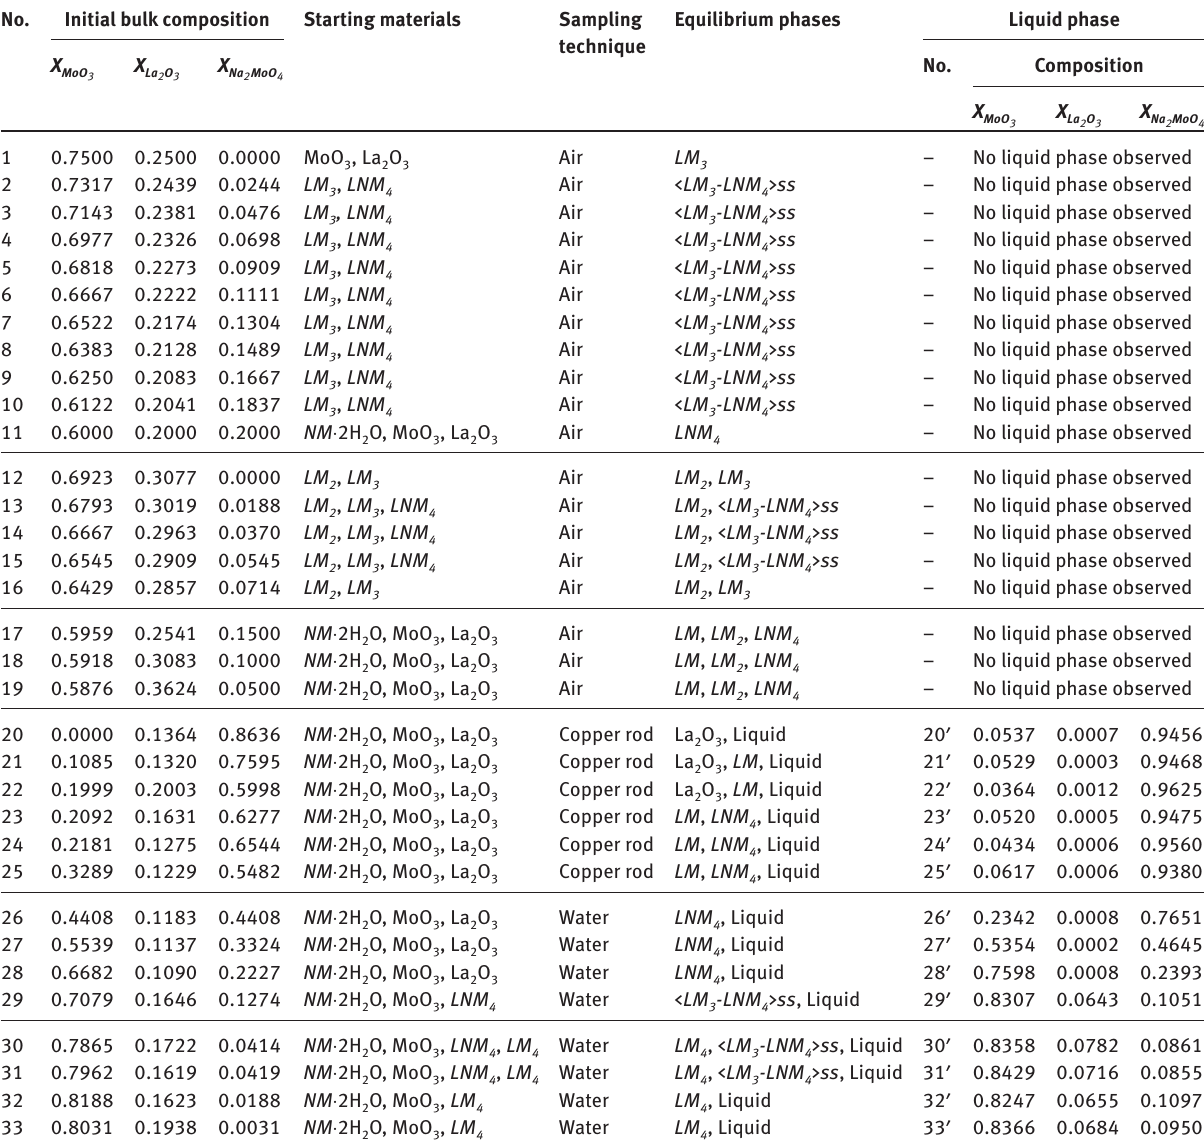
Table 1: Experimental results at 1073